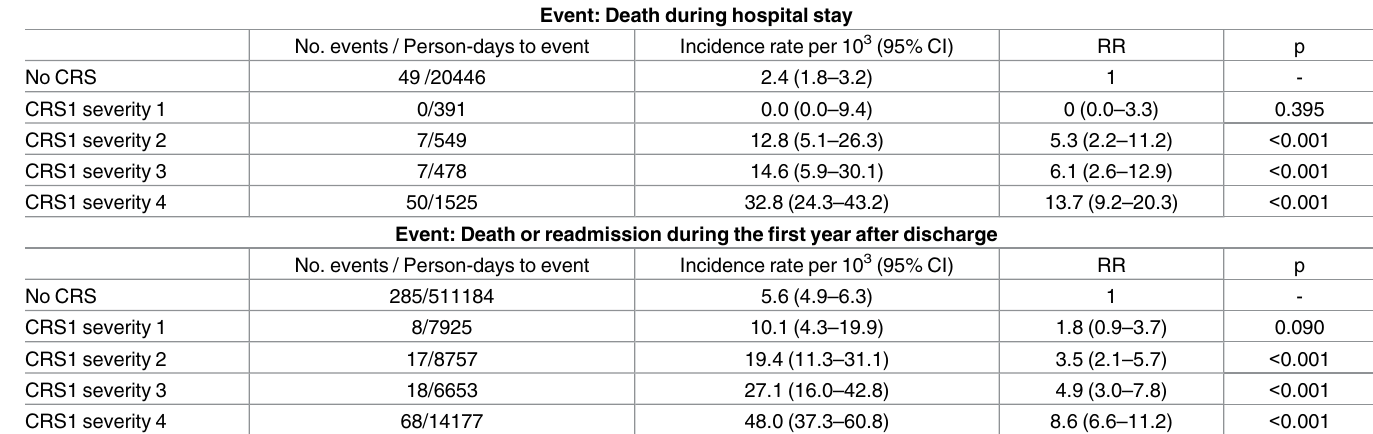
Table 3. Incidence rates according to the severityof CRS1. Comparison of rates (RR, 95% CI;